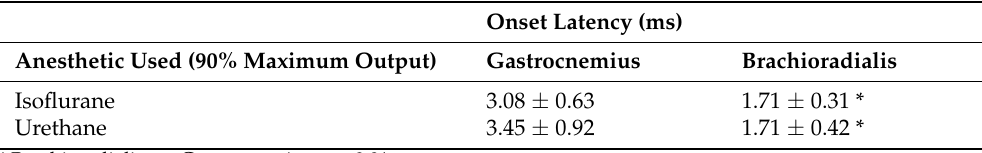
Table 1. Onset latency measured for gastrocnemius and brachioradialis motor evoked potentials at 90% of motor output.